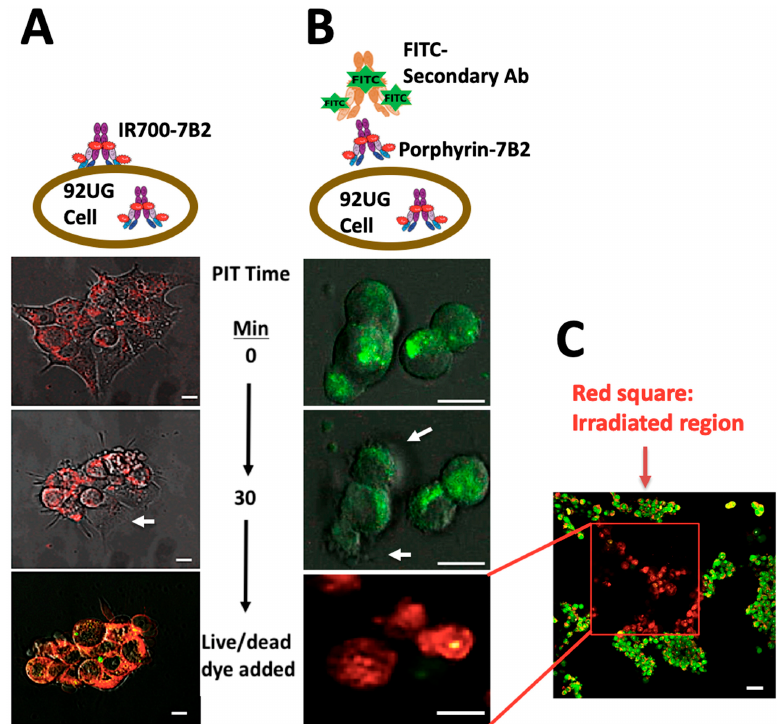
Figure 6. Target-specific cell death in response to PIT in HIV Env-expressing 293T cells. The cells were treated with IR700-7B2 ( A ) or 7B2-porphyrin ( B ) in the presence of sCD4 for 1 hour before laser irradiation by microscope. ( A ) The emitted red fluorescent from IR700-7B2 was directly detected. ( B ) 7B2-porphyrin was detected indirectly by using FITC anti-human IgG secondary antibody. After 30 minutes irradiation, the cell viability was studied by using Acridine Orange and Ethidium Bromide (Live/dead dye). White arrows indicate the bleb formation caused the necrotic cell death. The white bar indicates 10 µm. ( C ) The red square shows the irradiated region that the cells are dead (red color). The non-irradiated region (green color) signifies live cells, confirming no dark toxicity by PIC. The white bar indicates 20 µm.